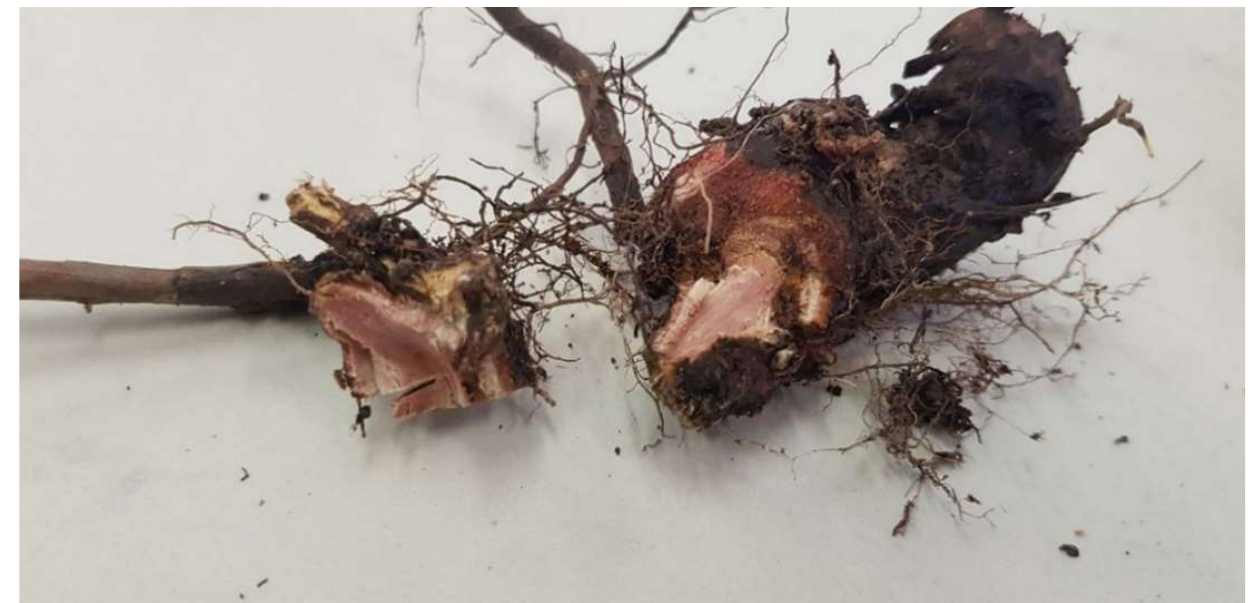
Figure 1. Plant nodular formations present on Rubus ulmifolius where the stem joins the roots below the soil surface. Table 1. Soil physico-chemical properties.